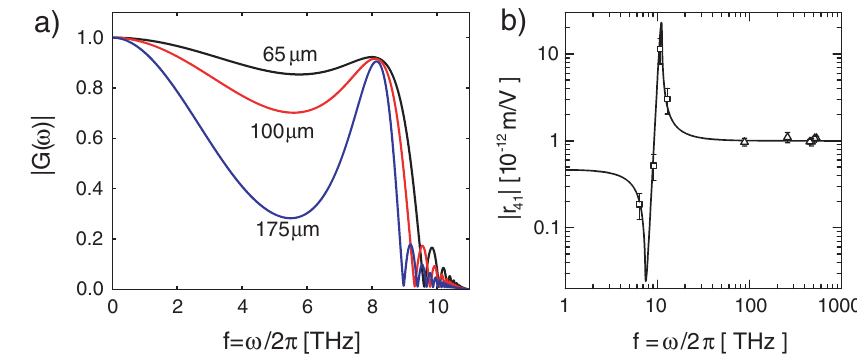
FIG. 3. (Color) (a) Absolute magnitude of the geometric response function of GaP for a crystal thickness of 65 (cid:1) m , 100 (cid:1) m , and 175 (cid:1) m . (b) Absolute magnitude of the EO coefficient r